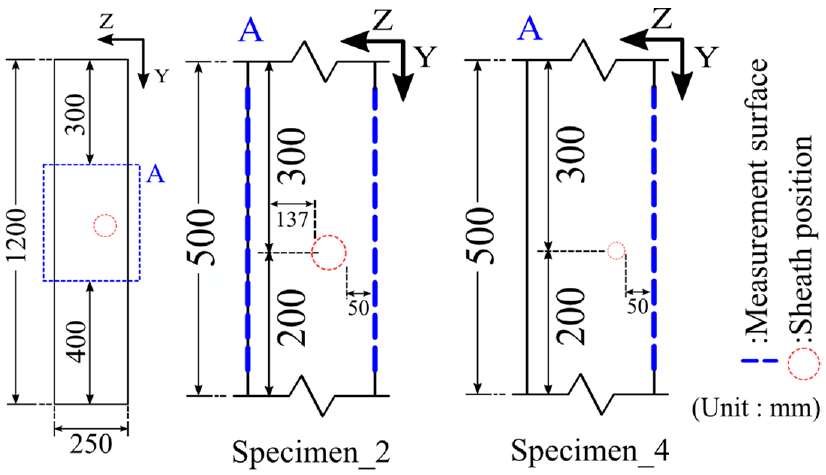
Figure 16. Cross-section view of specimen surfaces and configuration and the sheath.